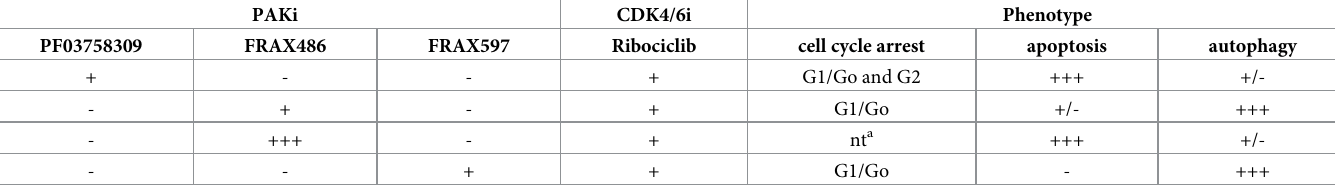
Table 4. Summary of drug treatment phenotype.